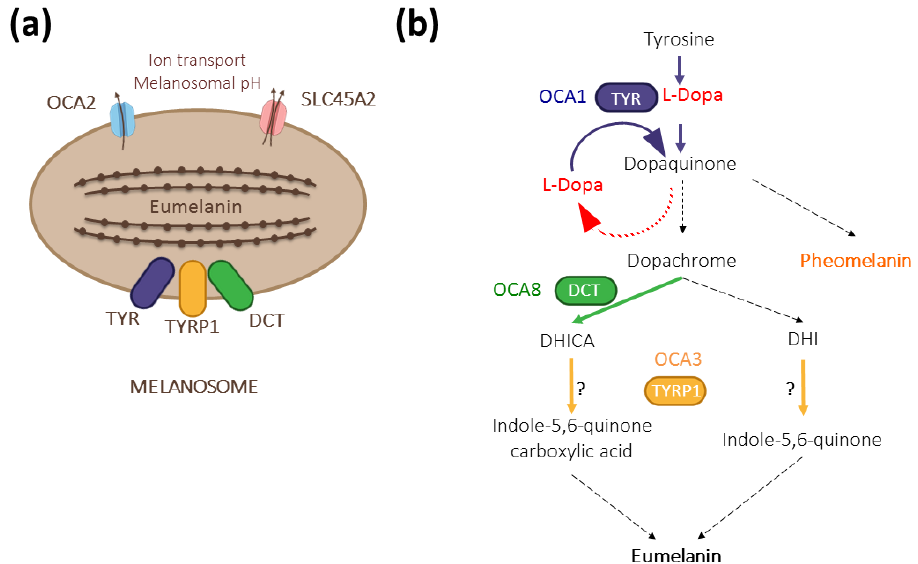
Figure 1. The contribution of DCT/TYRP2 (dopachrome tautomerase/tyrosinase-related protein 2) to melanogenesis. ( a ) Together with its paralogs TYR (tyrosinase) and TYRP1 (tyrosinase-related protein 1), DCT is anchored at the membrane of eumelanin-producing melanosomes with its enzymatic domain localized inside. The formation of a multienzymatic complex has been suggested [16,17] but has not been formally proven in vivo. Other major albinism genes, such as OCA2 (OCA2) and SLC45A2 (OCA4), encode regulators of melanogenesis by controlling the pH within the melanosome [18]. ( b ) As a melanogenic enzyme, DCT acts downstream of TYR and contributes to dark pigment synthesis by converting dopachrome to DHICA. TYR is the rate-limiting enzyme with both its hydroxylase and oxidase activities regulating the amount of L-Dopa in pigmented cells. TYRP1 may oxidize DHICA and/or DHI depending on the context [19,20]. Dashed arrows indicate spontaneous